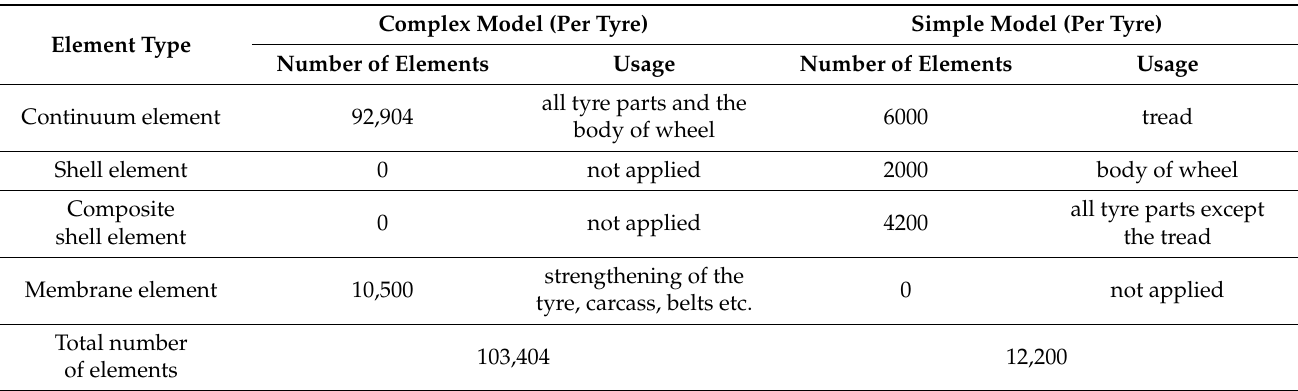
Table 7. Element types and the number of elements applied in the two types of finite element tyre